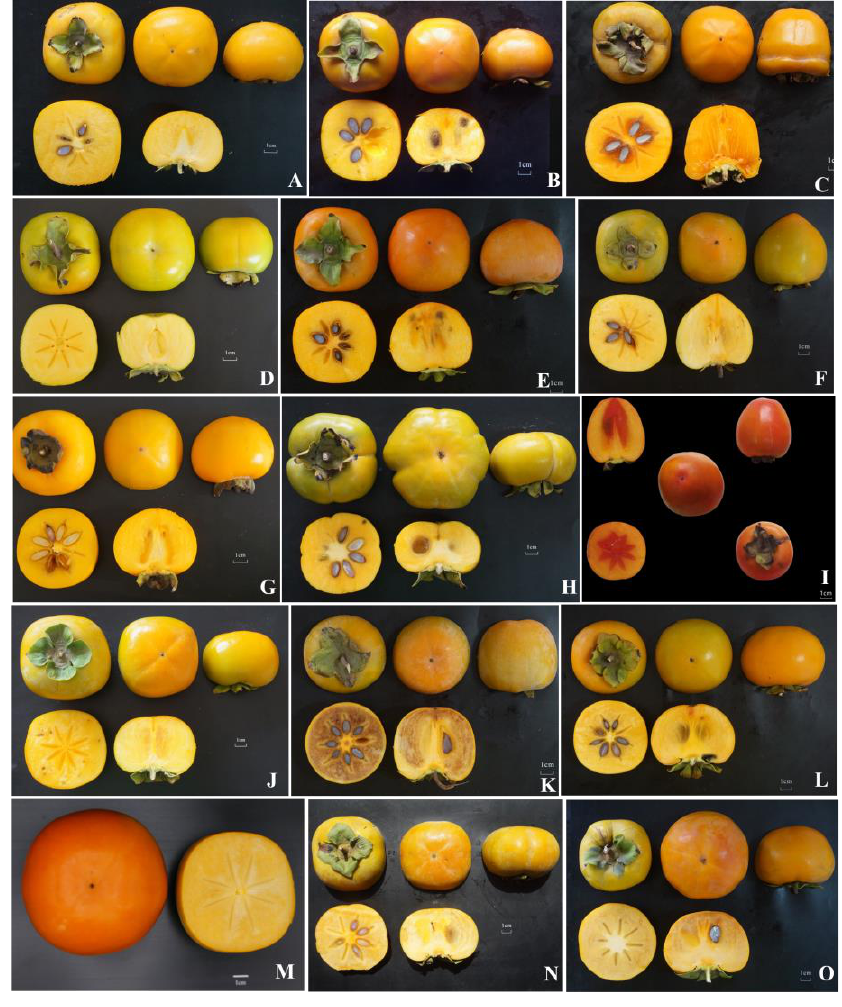
Figure 2. Fruit Profile diagram of four cultivated persimmon types. Note: PCA: ( A )~( I ). ( A ) Zhongshi No.5; ( B ) Huojing; ( C ) Boai_Bayuehuang; ( D ) Haian_Xiaofangshi; ( E ) Lishuishi; ( F ) Xinan_Niuxin; ( G ) Zhongshi No.6; ( H ) Lintong_Banshi; ( I ) Hongdenglong. PVA: ( J ) Tonewase. PVNA: ( K ) Zenjimaru. PCNA: ( L )~( O ). ( L ) Shinshuu; ( M ) Taishuu; ( N ) Kanshu; ( O ) Youhou.